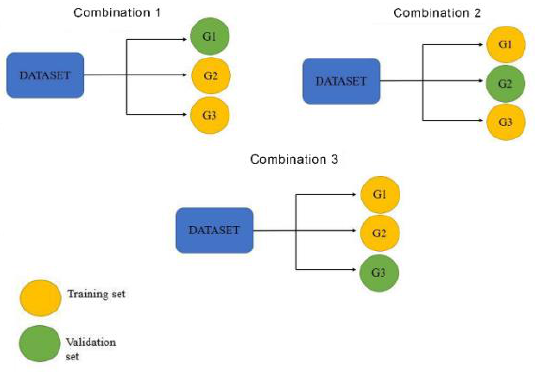
Fig. 5: Dataset cross-validation with three